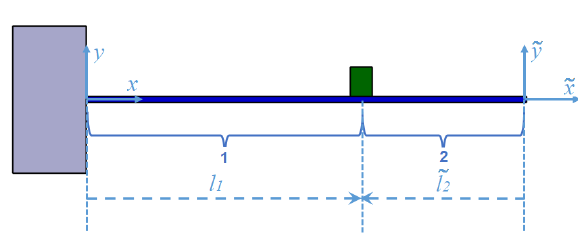
Figure 3. Cantilever beam with two different coordinate